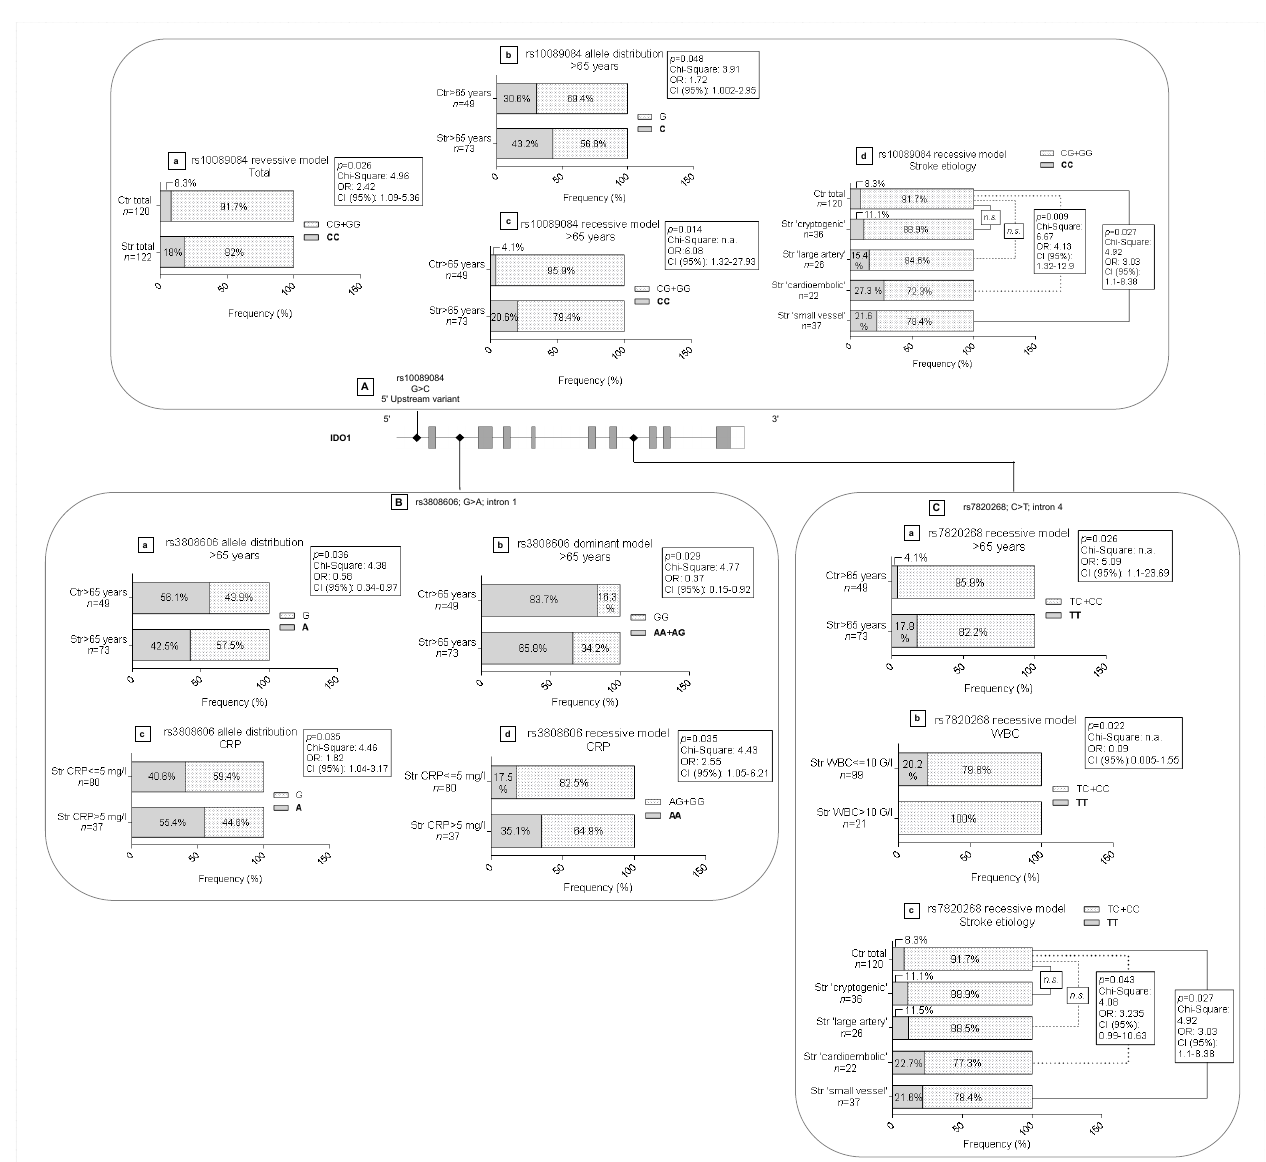
Figure 3. Detected significant differences in the frequencies of the studied IDO1 variants ( A – C ). Gene structure is illustrated with grey boxes indicating exons and small rhombuses the positions of SNPs studied. Graphs of allele frequencies are shown only for comparisons of groups and subgroups of stroke patients and controls where significant differences were detected ( a – d ), as indicated by statistical data in boxes. For a detailed description please see the text. Abbreviations: IDO1: indoleamine 2,3-dioxygenase 1; Ctr: control; Str: stroke; OR: odds ratio; CI: confidence interval; CRP: C-reactive protein; WBC: white blood cell; n.s.: